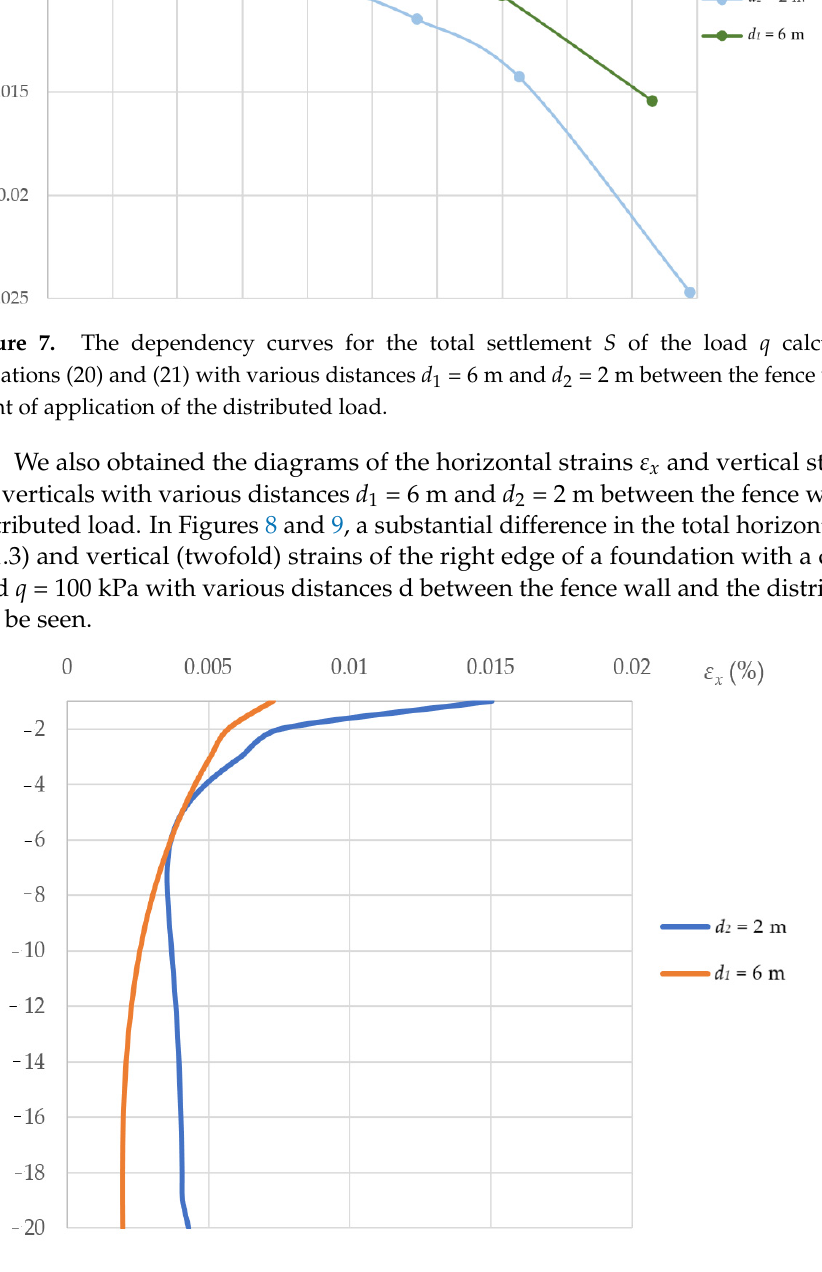
Figure 8. Diagram of horizontal strains ε x along the vertical line at distances d 1 = 6 m and d 2 = 2 m.